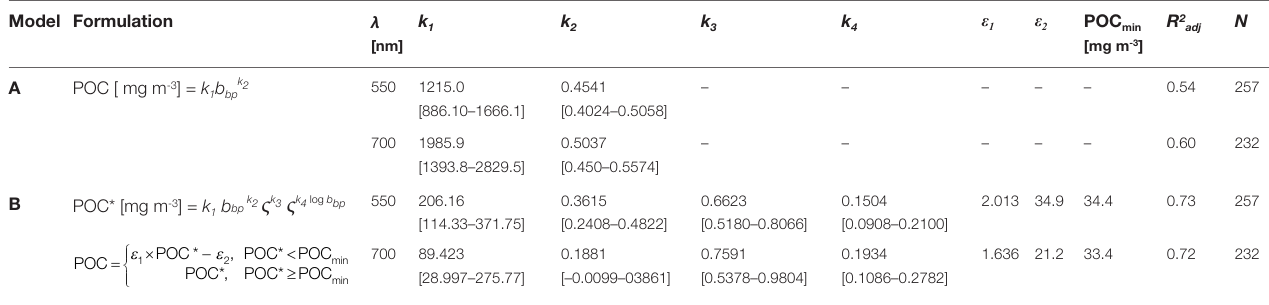
TABLE 4 | Regression models for